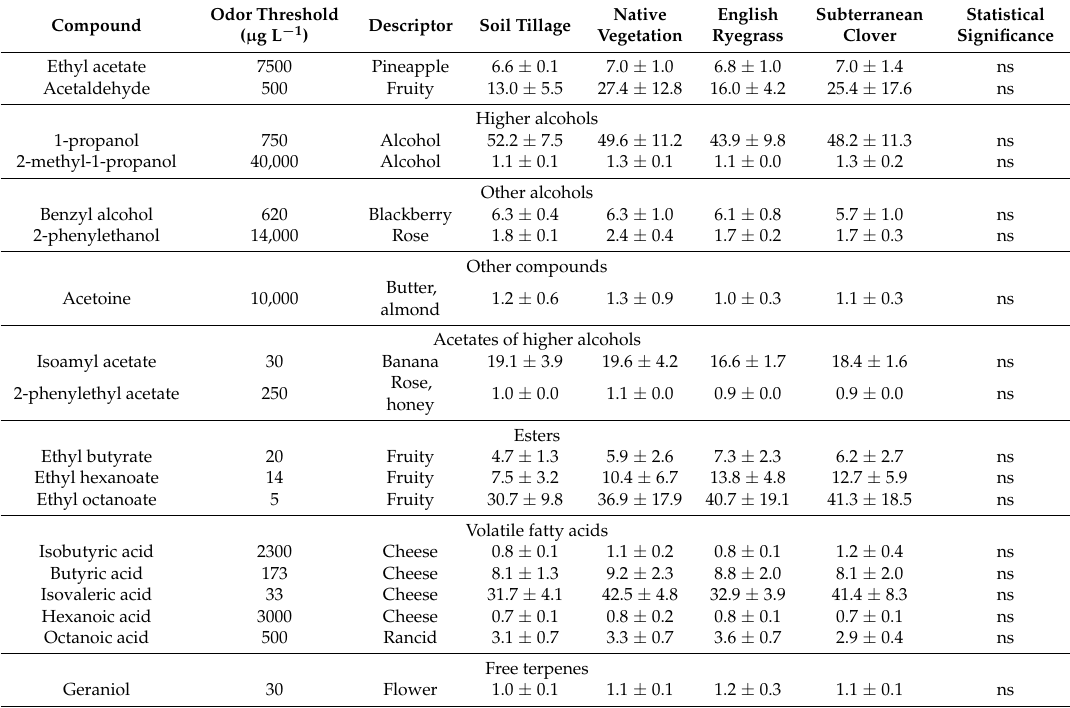
Table 6. Soil management effects on the odor activity values (mean ± standard error) of volatile compounds in wines from Menc í a averaged for three seasons